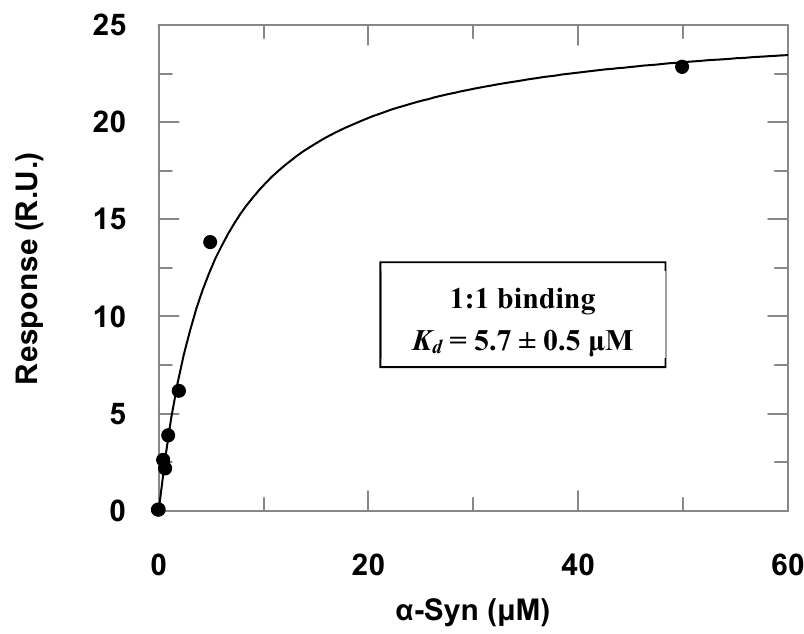
Figure 3. Dose–response data obtained in the surface plasmon resonance (SPR) assays with immobilized PREPL and α -Syn as the analyte injected at increasing concentrations (the correspondent adjusted sensorgrams are presented in the Supplementary Materials, Figure S3). The symbols represent the response in resonance units (RU) determined experimentally at each concentration of injected α -Syn, and the line is a fitted curve according to Equation (1).